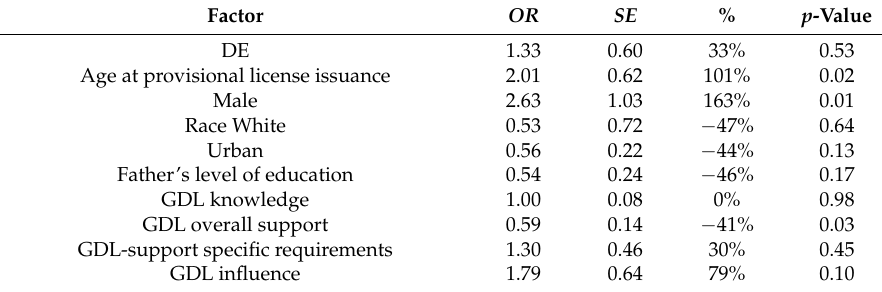
Table 2. Logistic regression with conviction versus no conviction as dependent